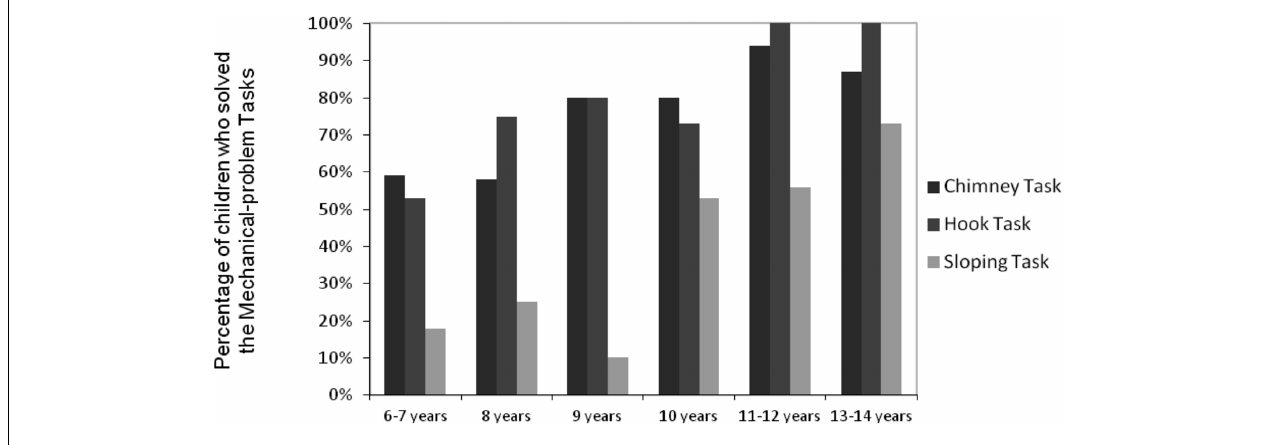
FIGURE 4 | Dichotomous scores of children according to age for the MPS tasks (Beck’s rating). TABLE 3 | Mechanical problem solving, real tool use, and functional knowledge accuracy-based scores system according to the age group. Chimney task Hook task Sloping